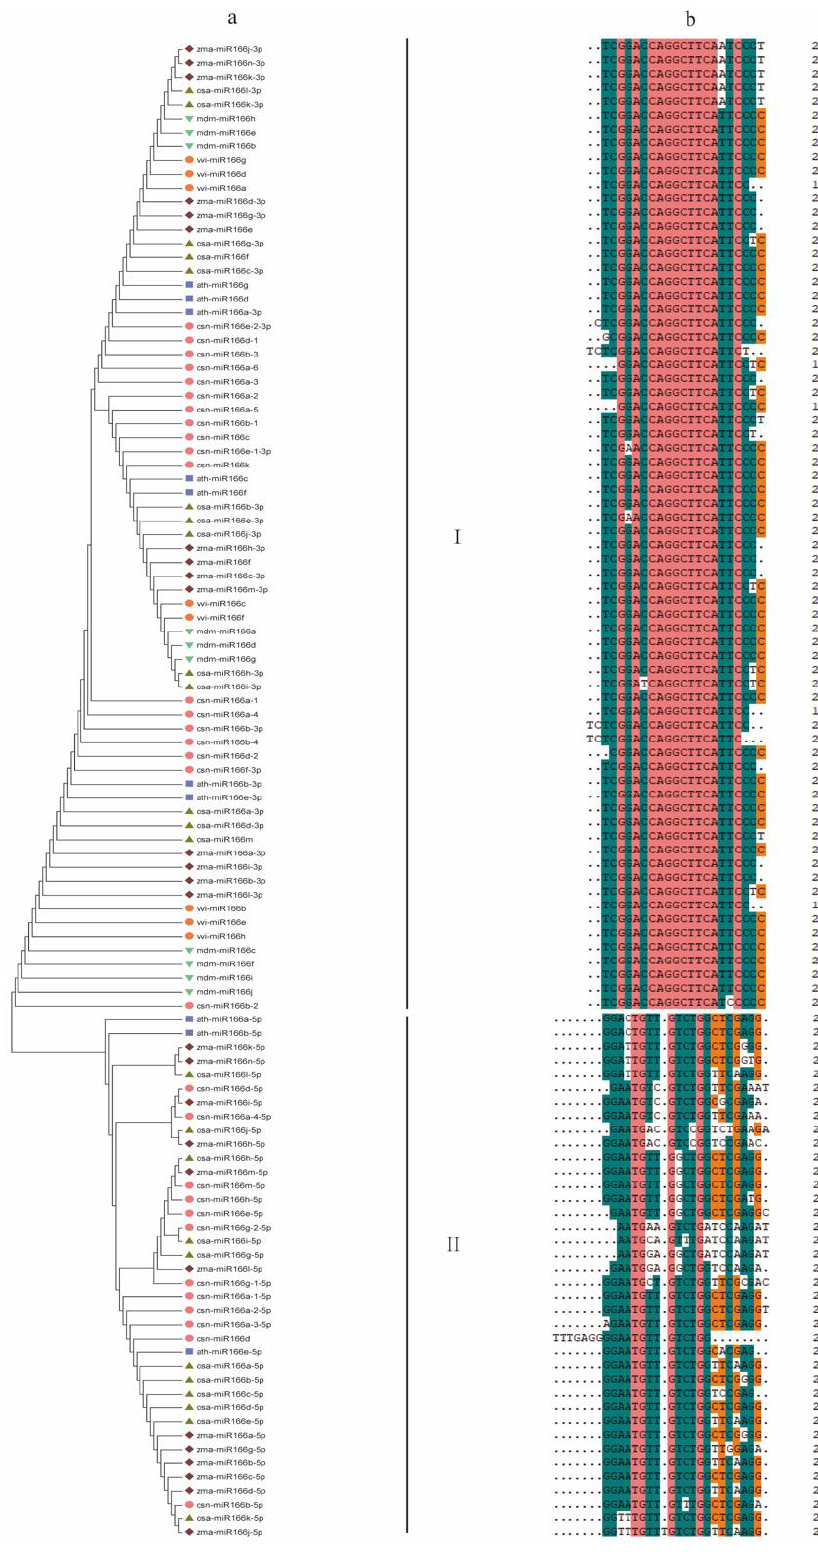
Figure 1. Analysis of mature miR166 sequences in selected plants. ( a ) Phylogenetic relationships analysis of csn-miR166s. ( b ) Sequence alignment analysis of csn-miR166s. vvi. Vitis vinifera L.; mdm. Malus domestica B.; osa. Oryza sativa L.; csn. Camellia sinensis (L.) O. Kuntze; ath. Arabidopsis thaliana (L.) Heynh; zma. Zea may L. Different highlight colors represent different homology levels of sequence. Pink. ≥ 100%; Green. ≥ 75%; Orange. ≥ 50%.